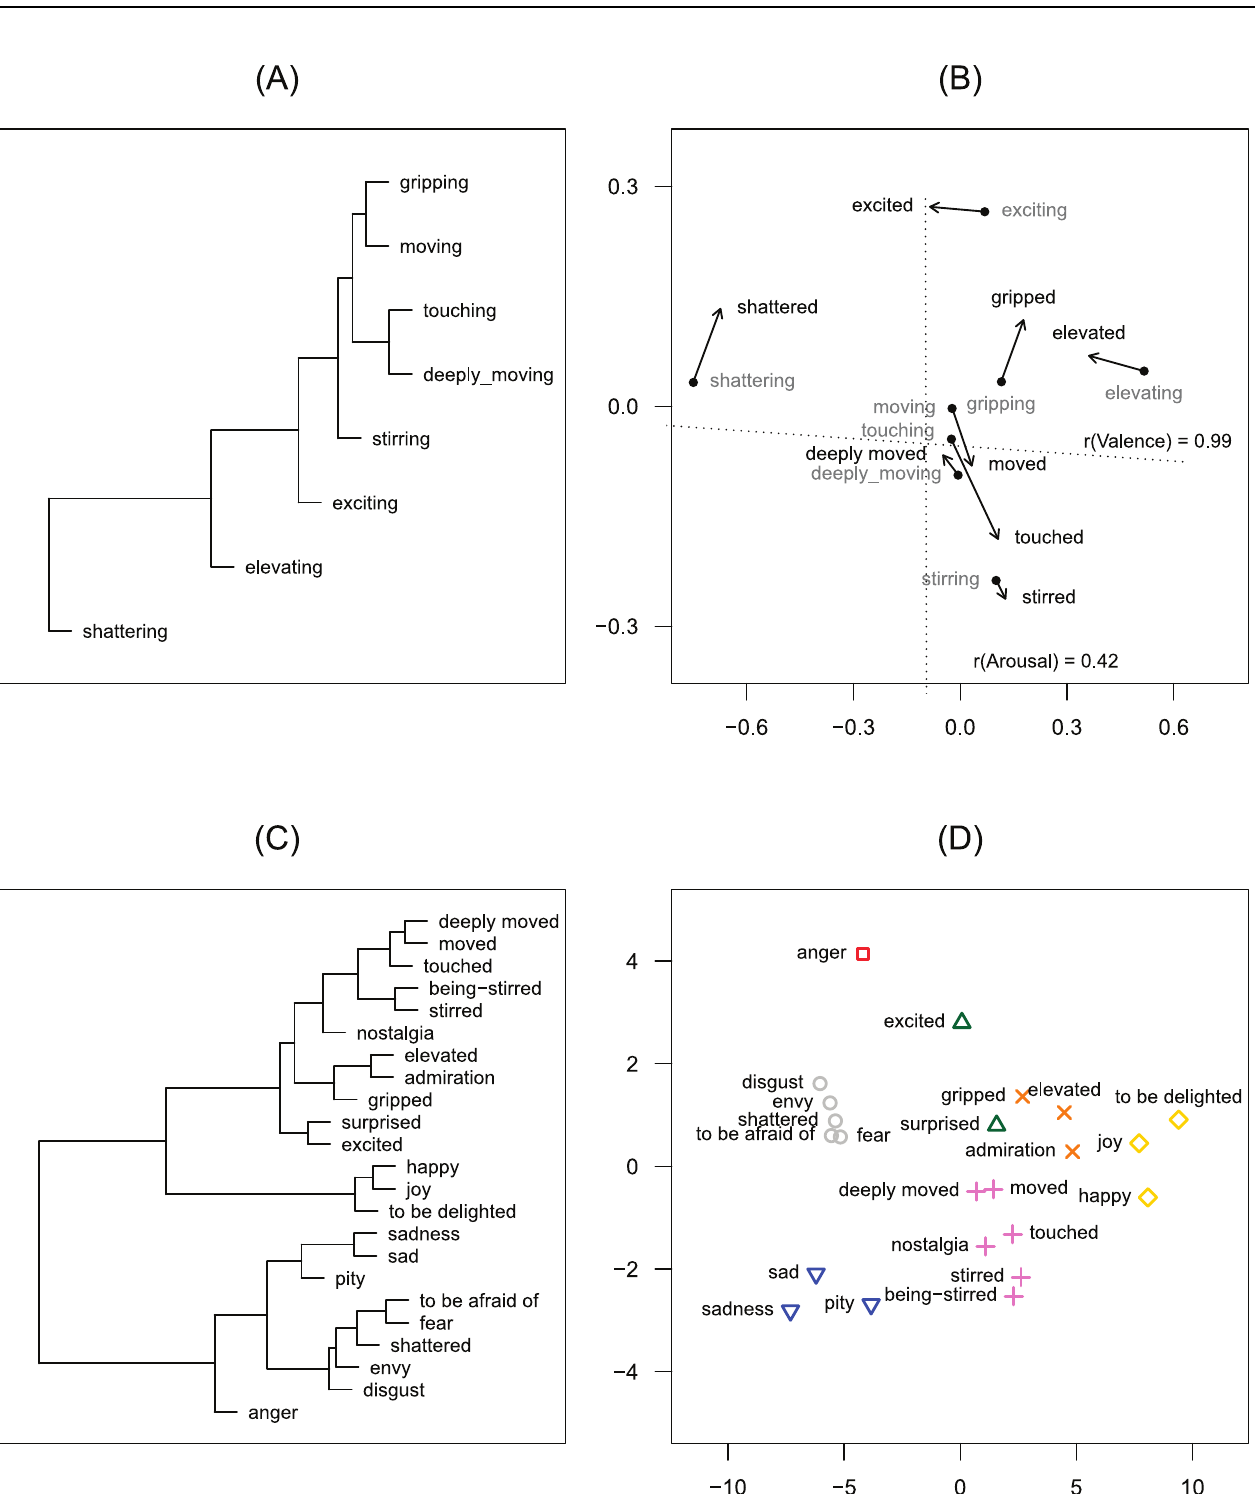
Fig 4. Cluster analysis dendrograms and MDS plots for Study 2 and Study 3. (A) Cluster analysis dendrogram for Study 2. (B) MDS Plot of the Procrustes analysis of MDS solutions of the eight emotion terms common to Study 2 and Study 3; the starting points of the arrows represent the emotion terms according to the MDS of Study 2, while the end points of the arrows represent the emotion terms according to the MDS of Study 3; the dotted lines represent the BAWL-R-based variables valence and arousal, fitted into the plot. (C) Cluster analysis dendrogram for all 23 emotion terms of Study 3. (D) MDS plot for all emotion terms of Study 3; symbols represent the seven clusters found by the cluster analysis (see main text for details).